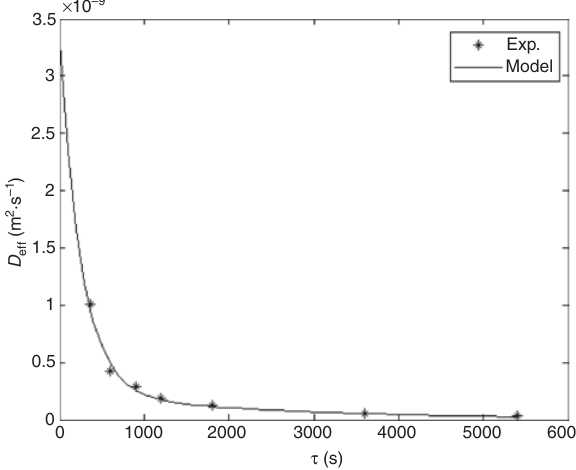
Figure 6: Experimental data and model curve of D t = 20 ° C and ξ = 0.04 m 3 /kg.